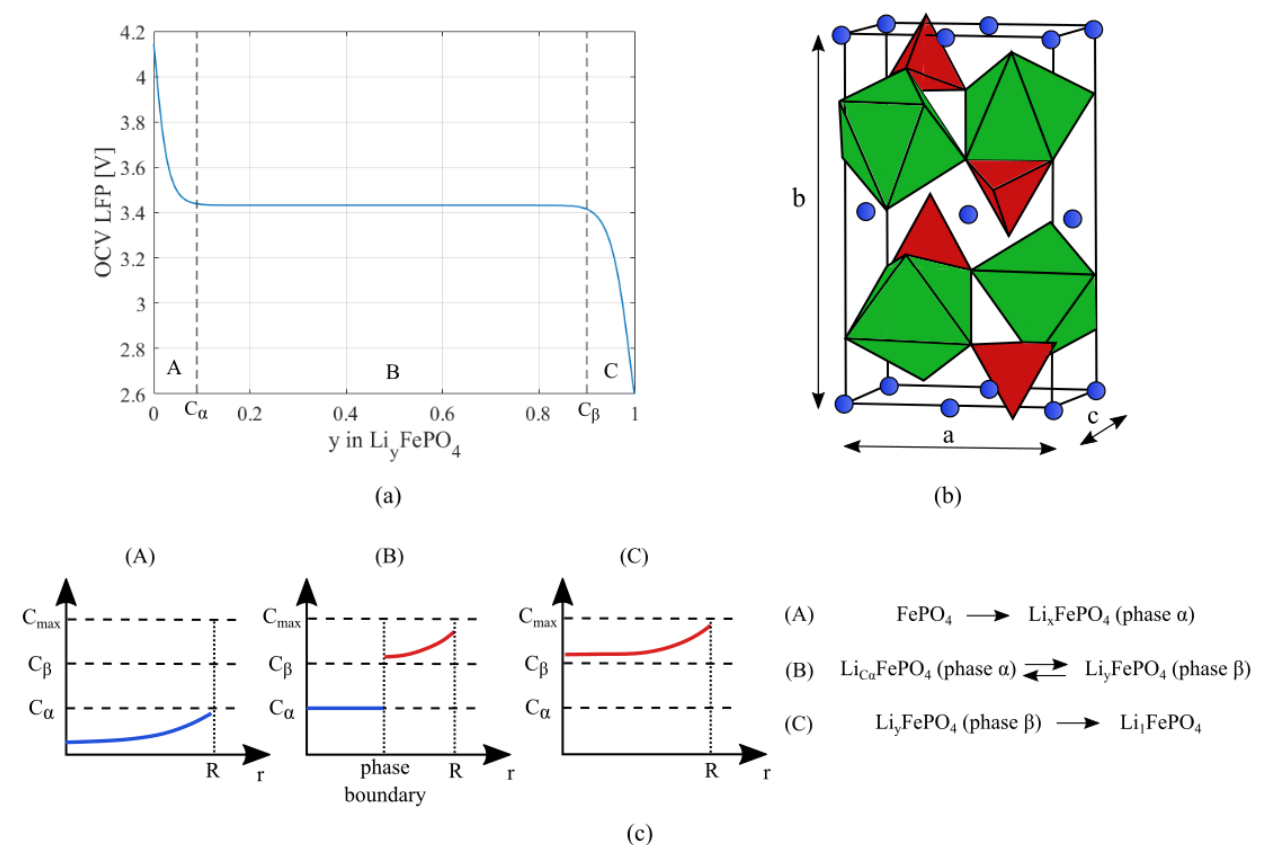
Figure 2. OCV of LFP ( a ) and description of phase transition ( c ): blue lines refer to Li-poor phase, and red lines refer to Li-rich phase. Crystal structure of LiFePO 4 correlated with its lattice parameters ( b ): tetrahedra refer to PO 4 , octahedra to FeO 6 and blue spheres to lithium ions